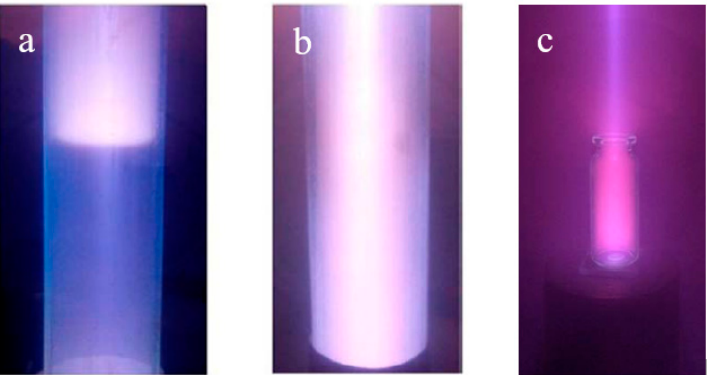
Figure 17. Plasma glow created in a dielectric cavity at a beam energy of 7 keV and a beam current of 20 mA, air pressure: ( a )—1.5 Pa, ( b )—4 Pa [124]. Beam-plasma sterilization: ( c )—medical glass bottle of 10 mL.